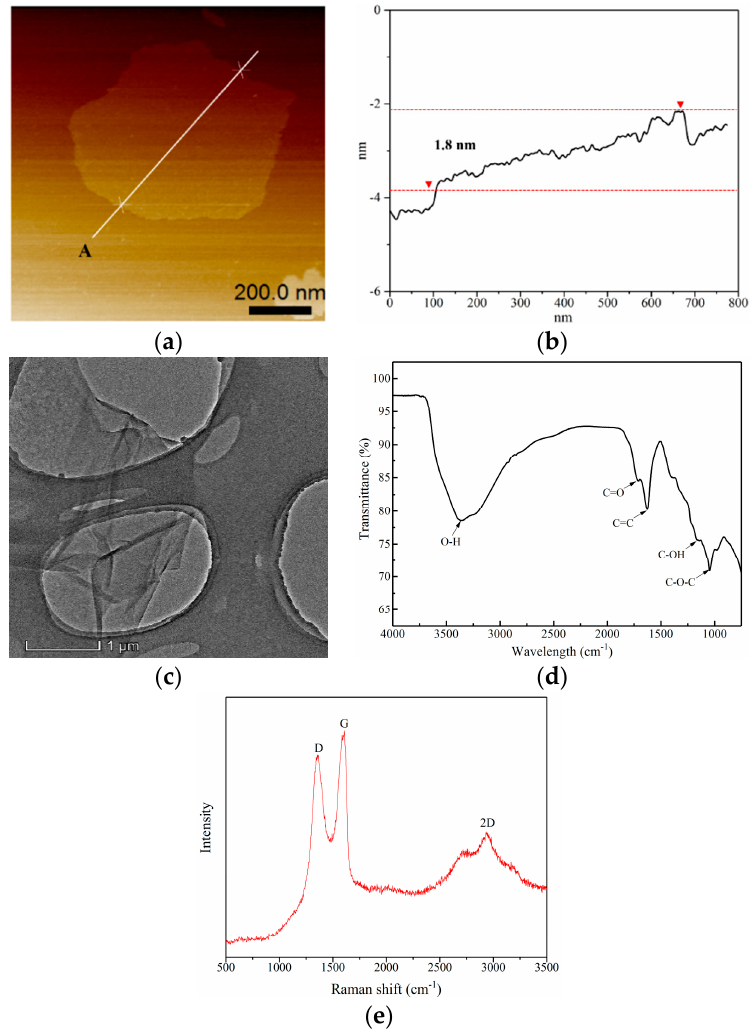
Figure 4. Characterization of GO: ( a ) AFM image; ( b ) AFM spectra; ( c ) TEM image; ( d ) FTIR transmittance spectra; and (e) Raman spectrum.